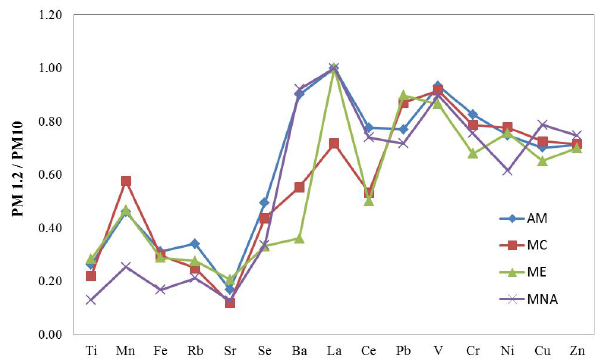
Fig. 5. Fine (PM 1 . 2 ) to coarse (PM 10 ) ratios for measured trace elements in the four major air mass footprints representative of the aerosol background at